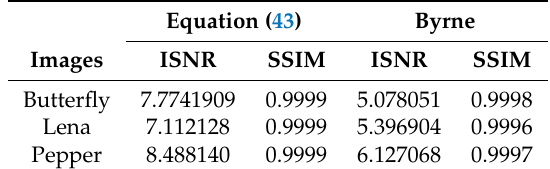
Table 2. The ISNR and SSIM values of the compared algorithms.